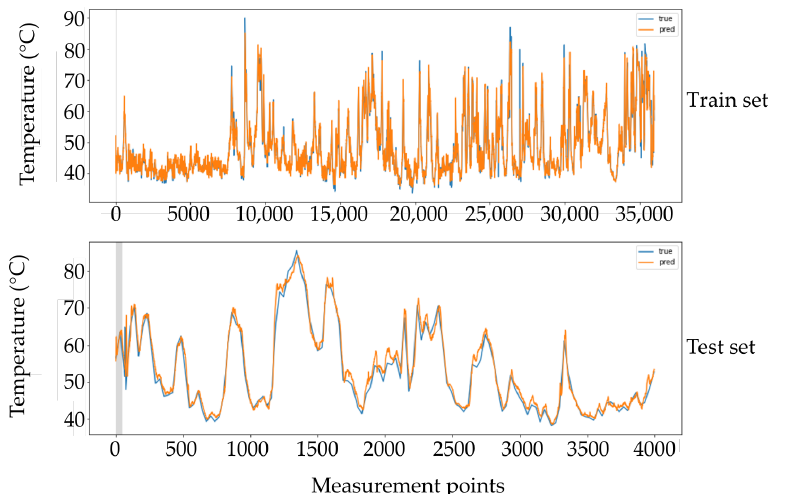
Figure 14. True versus predictive behavior of the gated recurrent unit (GRU) model. Training and test sets in one of the output